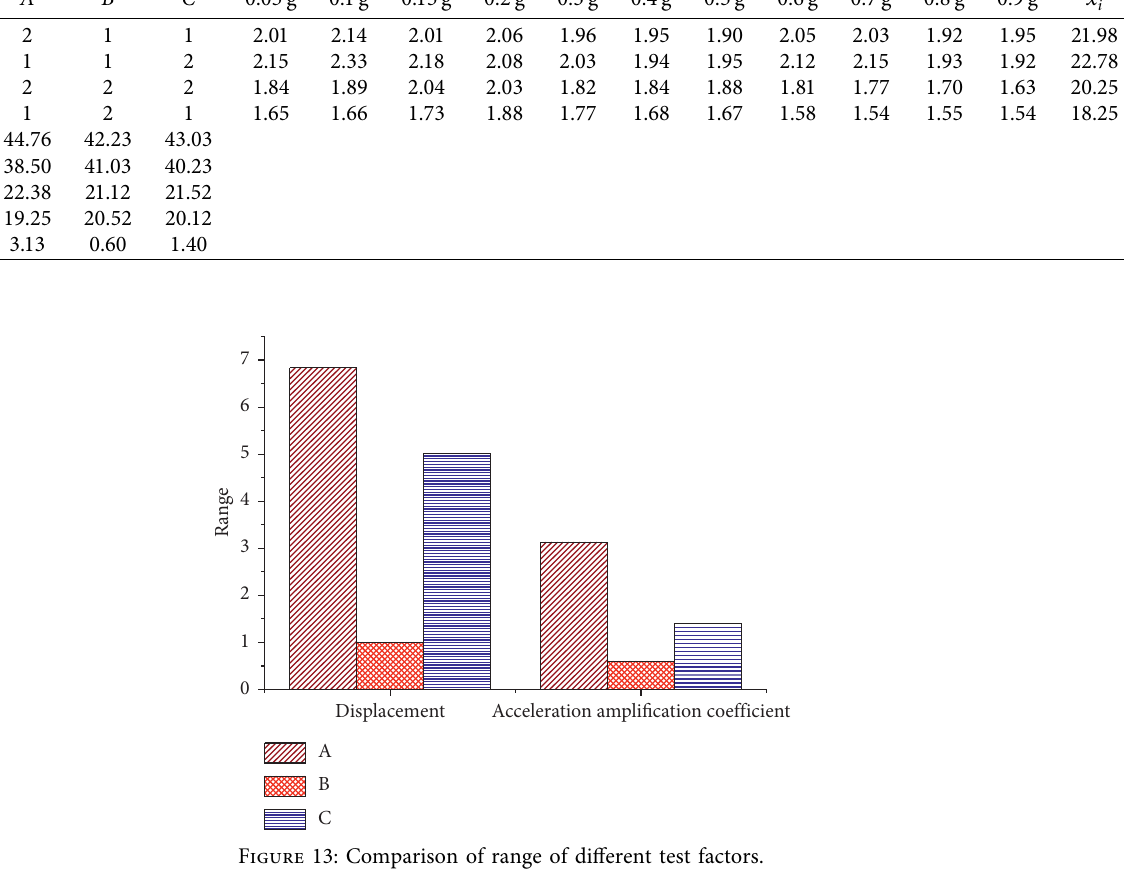
Table 8: Analysis of result of acceleration amplification coefficient at the top of the wall. Specimen